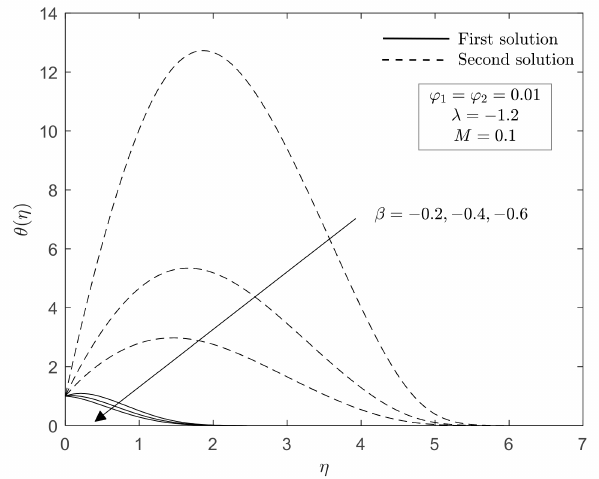
Figure 7. Temperature profile θ ( η ) for selected values of heat sink β (Shrinking sheet case) when M = 0.1.